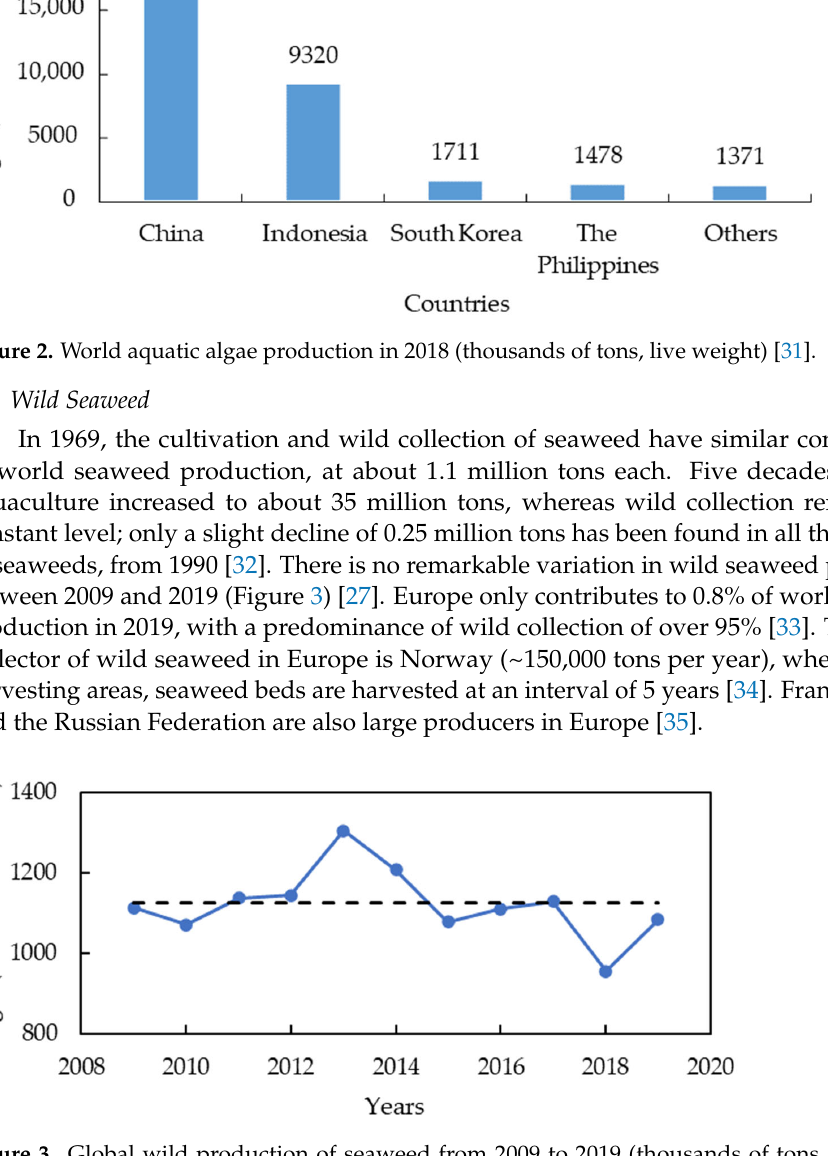
Figure 3. Global wild production of seaweed from 2009 to 2019 (thousands of tons, dotted line: average level, adapted from [27]).